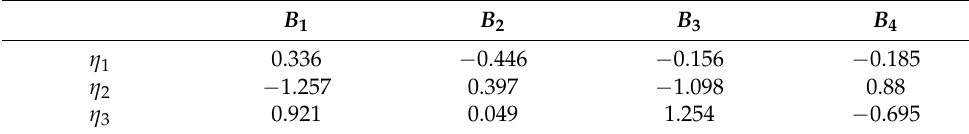
Table 5. Different decision factors relative to open-pit slope risk.